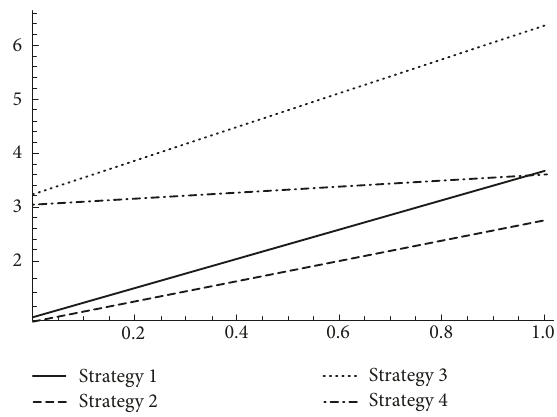
Figure 4: Revenue of new theme film under different strategies.